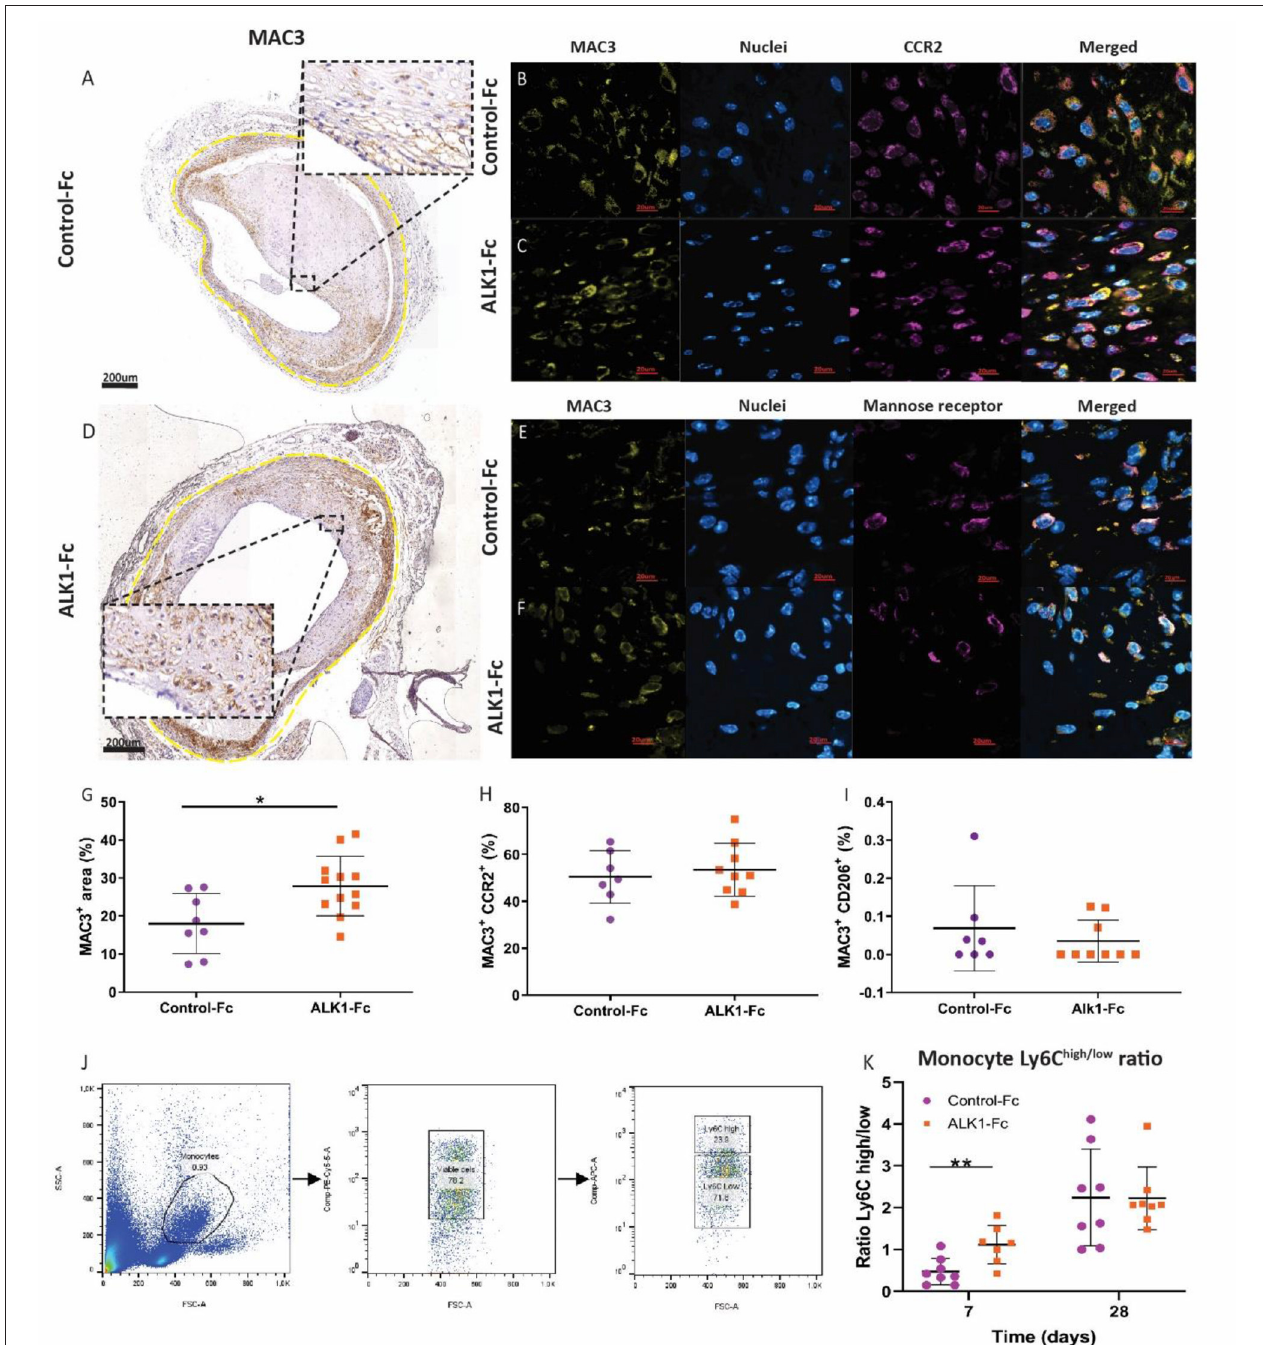
FIGURE 4 | Macrophage content and polarization in vein grafts from ALK1-Fc or control-Fc treated mice. ALK1-Fc treated mice ( n = 11) were compared to control-Fc treated mice ( n = 8). Representative examples of a MAC3 (CD107b) (A) , MAC3, and CCR2 (CD192) from a control-Fc treated mouse (B) and an ALK1-Fc treated mouse (C,D) . MAC3 and the mannose receptor (CD206) from a control-Fc treated mouse (E) and an ALK1-Fc treated mouse (F) . The relative presence of the macrophages was identified in the vessel wall via calculation of a percentage area (G) . Double positive integrated densities of MAC3 and CCR2 positive macrophages (H) and MAC3 and mannose receptor-positive macrophages (I) areas were calculated. Monocytes in the blood that expressed Ly6C represented as a high/low ratio (J,K) . Statistical evaluation was performed with the unpaired parametric T -test, * p < 0.05, ** p < 0.01.